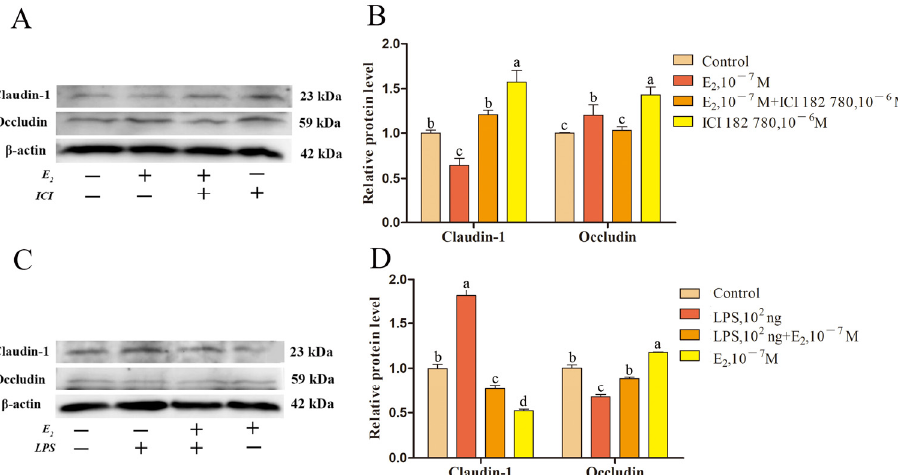
Figure 10. LPS affects claudin-1 and occludin protein expression in endometrial epithelial cells via E 2 receptors. ( A ) Western blotting of E 2 and ICI 182,780-treated epithelial cells. ( B ) Relative expression level of epithelial cell proteins treated with E 2 and ICI 182,780. ( C ) Western blotting of LPS and E 2 -treated epithelial cells. ( D ) Relative expression level of epithelial cell proteins treated with LPS and E 2 . Different lowercase letters indicate a significant difference at p < 0.05. ICI 182,780, 17 β -estradiol receptor inhibitor. Concentration is measured in mol/L.